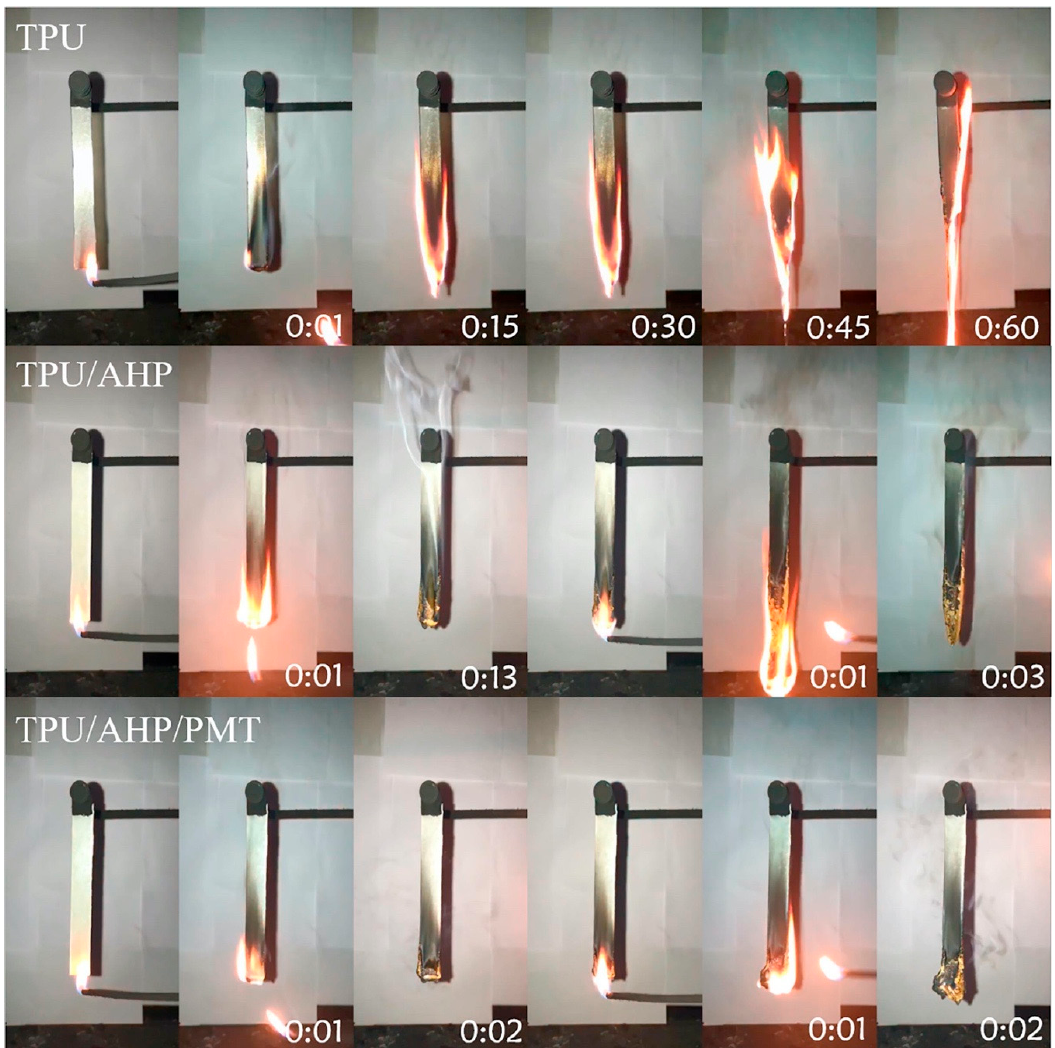
Figure 3. Video screenshots of TPU (thermoplastic polyurethane), TPU / AHP (thermoplastic polyurethane containing 10 wt. % of aluminum hypophosphite) and TPU / AHP / PMT (thermoplastic polyurethane containing 9 wt. % of aluminum hypophosphite and 1 wt. % of exfoliated montmorillonite decorated with phosphorylated chitosan) composites during UL-94 testing. Reprinted with permission from [30]. Copyright 2019, Elsevier.